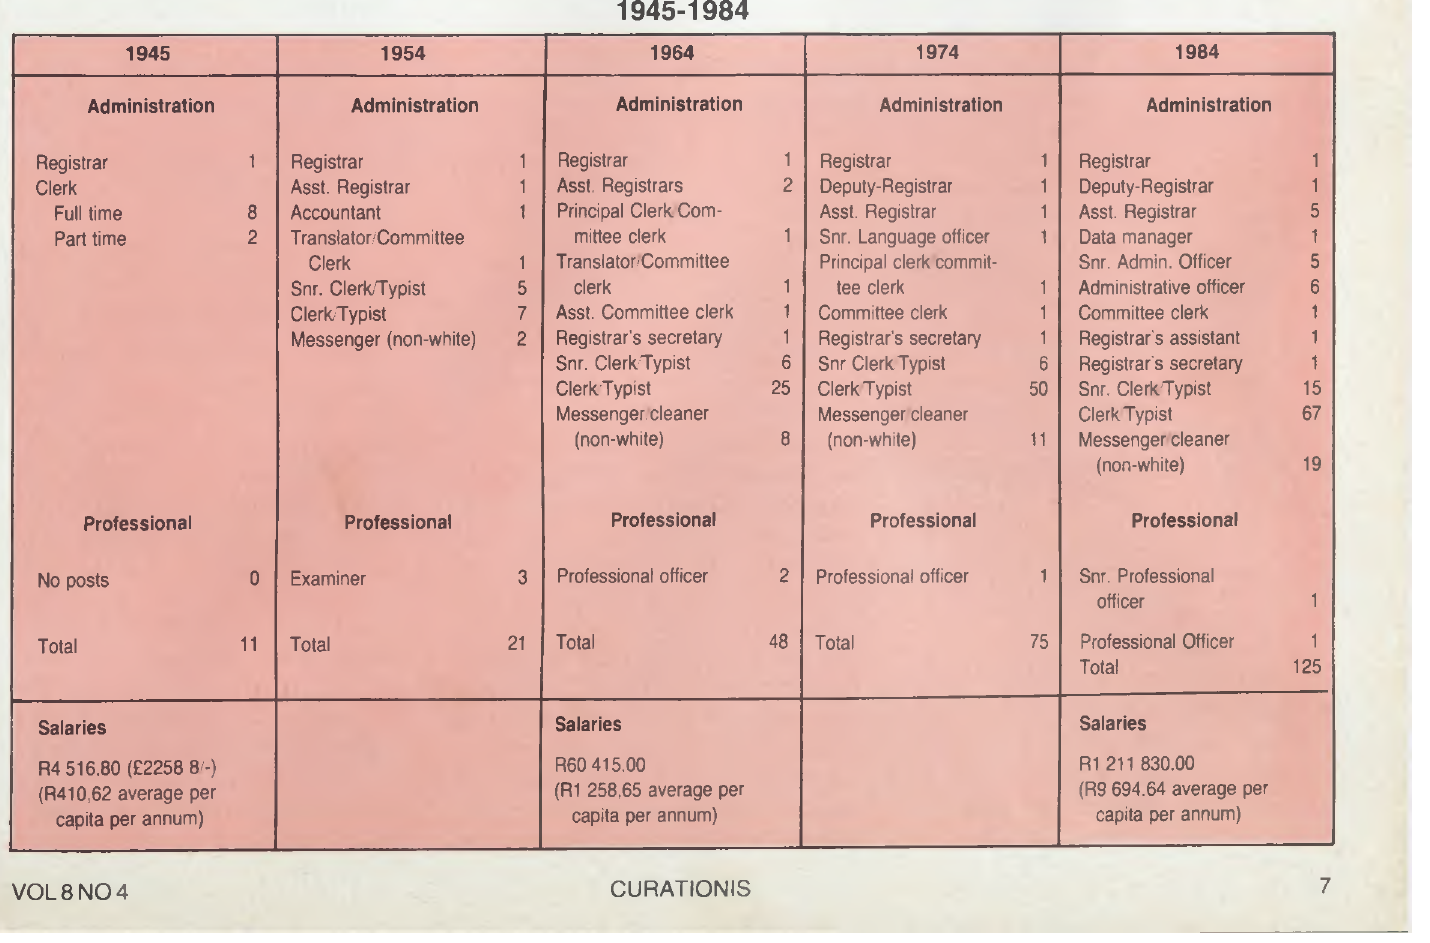
Table 2 Development of the post-structure of the South African Nursing Council Head